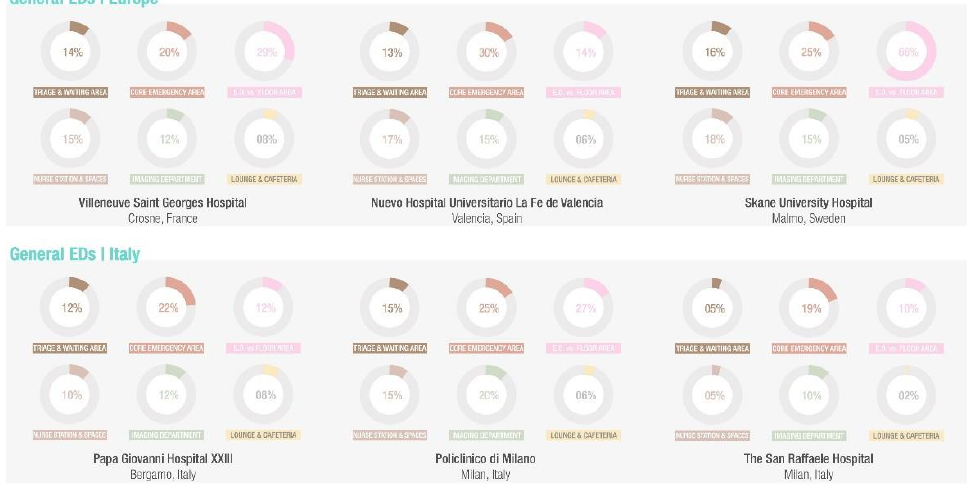
Figure 10. Results from the data analysis of HBED Functional areas.